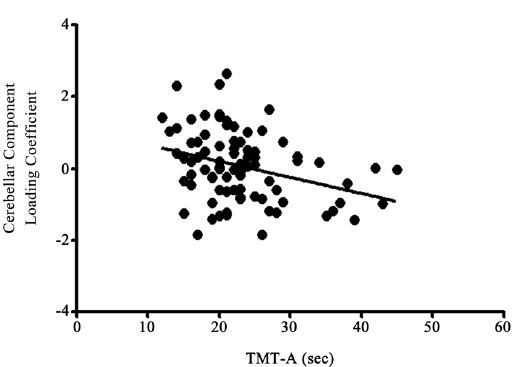
Figure 3. The association between the cerebellar component and results from the Trail Making Test, Part A